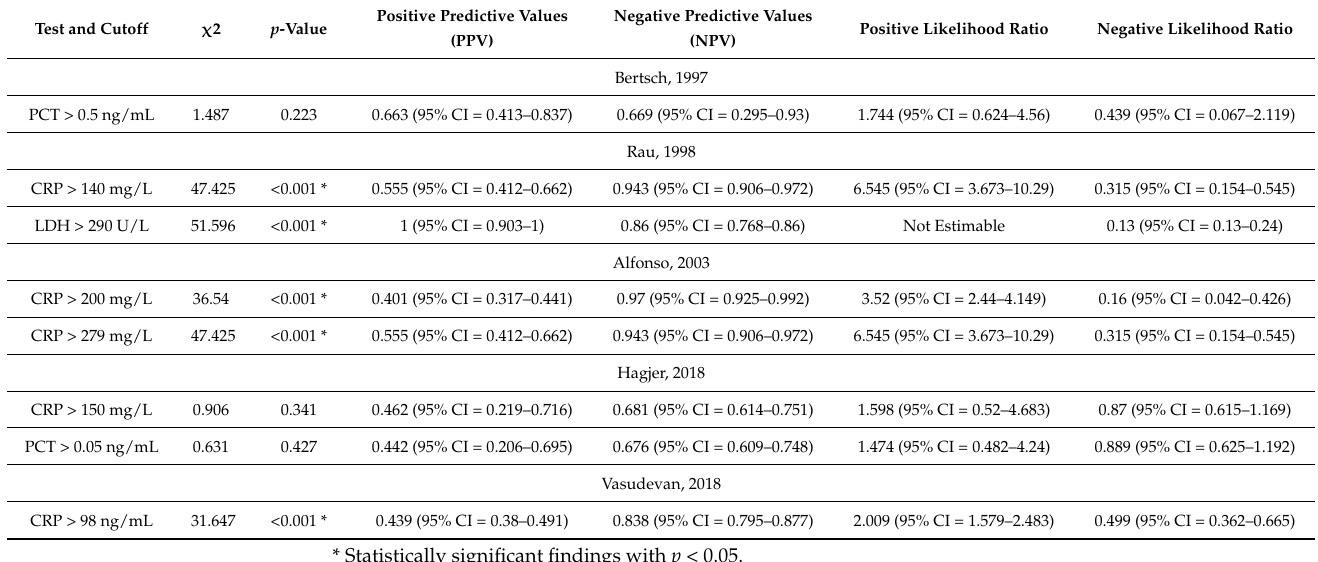
Table 3. Tabulated summary of meta-analytical findings presenting χ 2, p -value, PPV, NPV, positive likelihood ratio, and negative likelihood ratio.